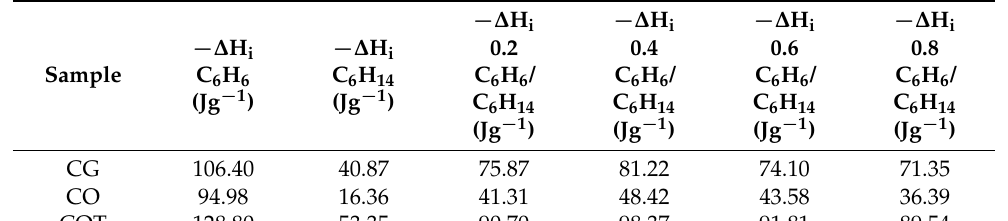
Figure 6. Calorimetric curves of CG, CO and COT immersion in pure solvents (benzene and hexane).